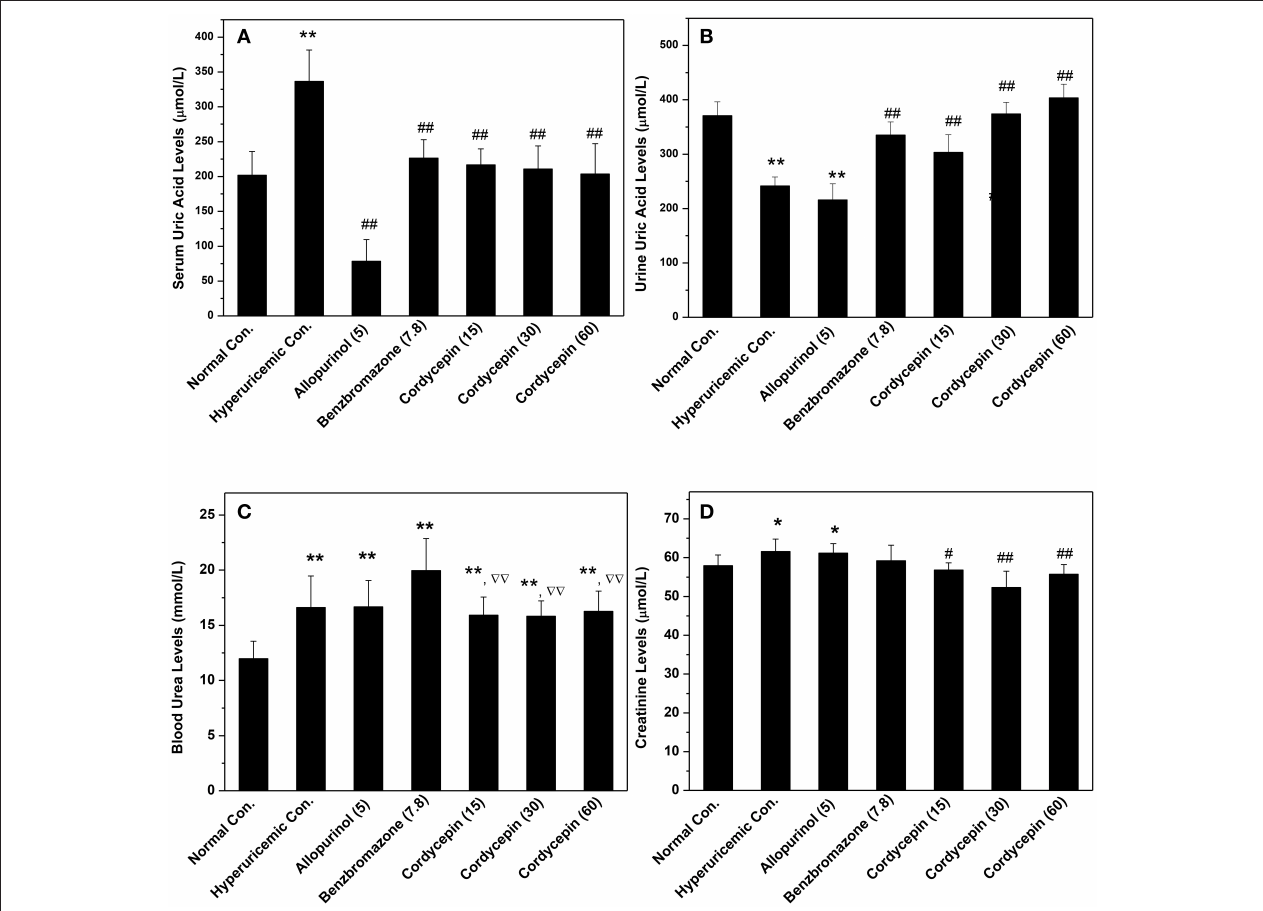
FIGURE 2 | Influence of cordycepin on (A) SUA, (B) UUA, (C) serum creatinine, and (D) BUN. * P < 0.05, ** P < 0.01 vs. normal control; # P < 0.05, ## P < 0.01 vs. hyperuricemic control; 11 P < 0.01 vs. allopurinol control.